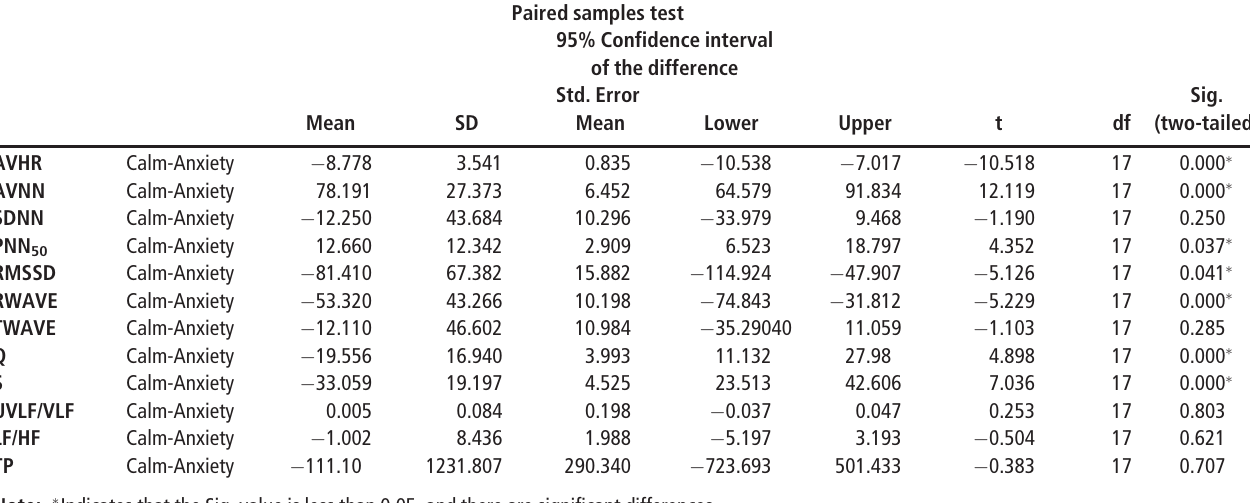
Table VII Paired T-test results of driver ’ s ECG characteristics in calm and anxiety